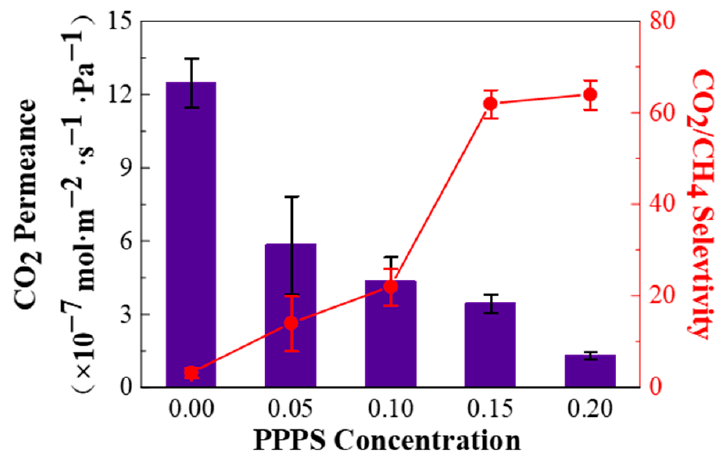
Figure 6. Effect of different PPPS concentrations on the CO 2 /CH 4 (45/55 vol%) mixed gas separation performance of PPPS/PDMS/PSf composite membrane. Test conditions: 298 K, saturated humidity, and 0.15 MPa.